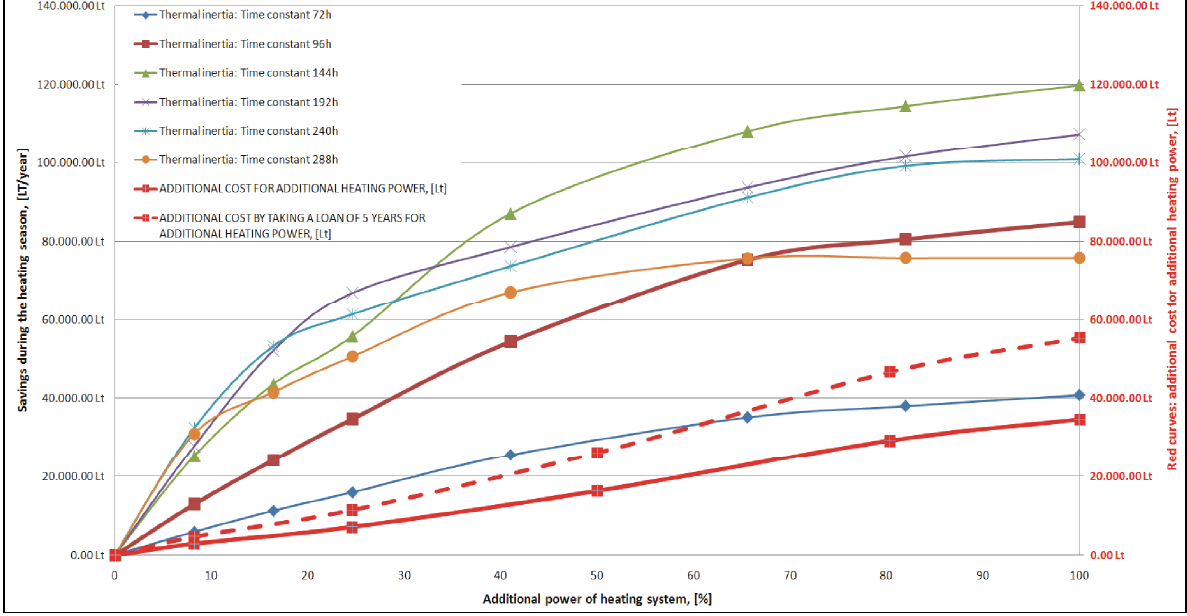
Fig. 11. Savings of thermal energy during 5 years (heating seasons) by use of intermittent heating and additional power of heating system in various cases of thermal time